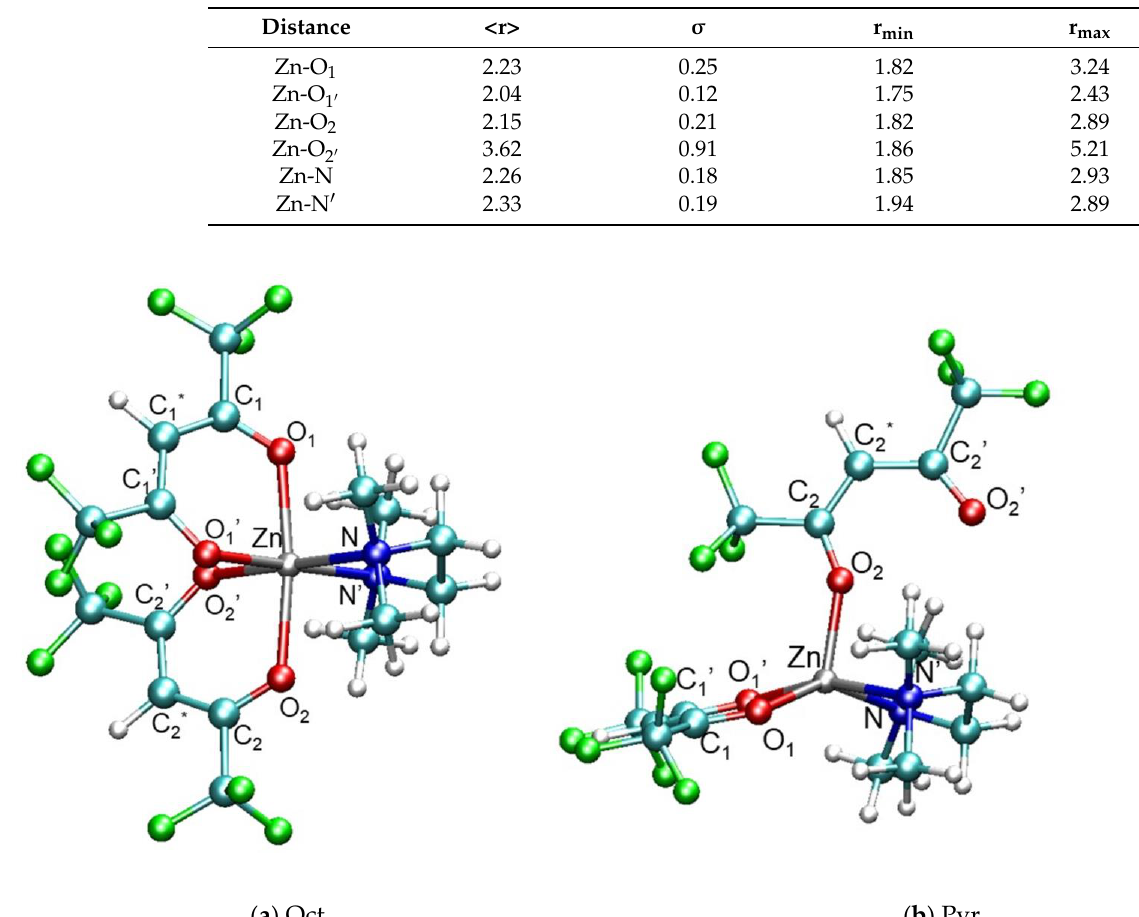
Figure 2. Optimized geometries of the ( a ) octahedral and ( b ) pyramidal forms of the complex Zn(hfa) 2 TMEDA (computed at the M06/D95+(d,p) level of theory). ( a ) Octahedral complex (Oct), which is the minimum energy structure, evidencing the pseudo-octahedral Zn coordination environment. ( b ) Pyramidal complex (Pyr), highlighting the breakage of the bond between the β-diketonate oxygen O 2′ and the Zn center. Pyr is higher in energy than Oct by 13.06 kcal/mol at the M06/D95+(d,p) level, and by 10.02 kcal/mol at the PBE-D2/PW level. C 1 * and C 2 * indicate the central C atoms of the hfa ligands. Color codes: Zn, grey; F, green; O, red; N, blue; C, cyan; H,